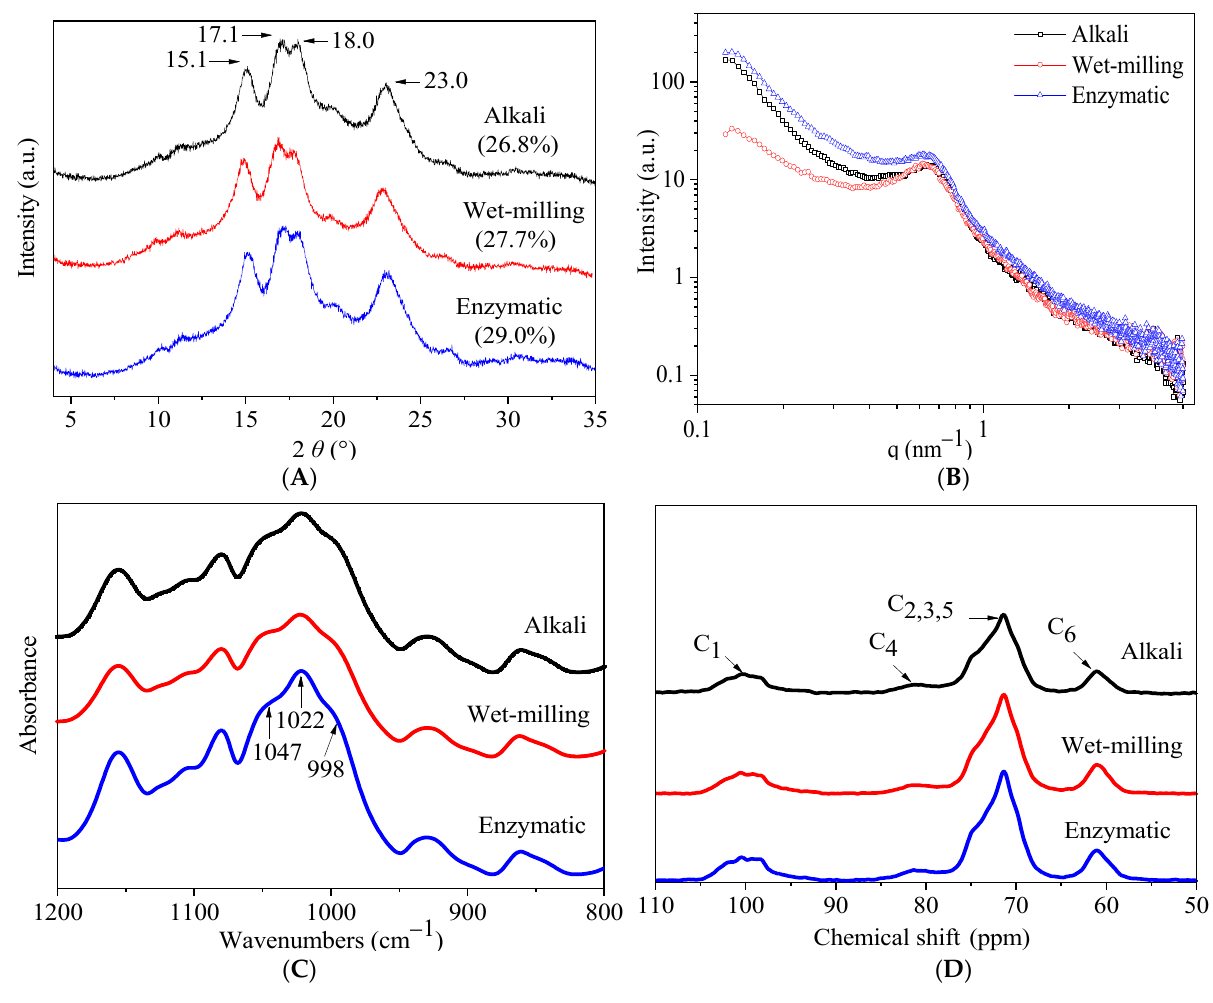
Figure 2. XRD ( A ), SAXS ( B ), FTIR ( C ), and NMR ( D ) spectrum of quinoa starch isolated by three different methods (alkali, wet-milling, and enzymatic). The XRD values in parentheses show the relative crystallinity of quinoa starch. Table 2. Multi-scale structure and molecular weight changes in quinoa starch isolated by three different methods (alkali, wet-milling, and enzymatic) A .